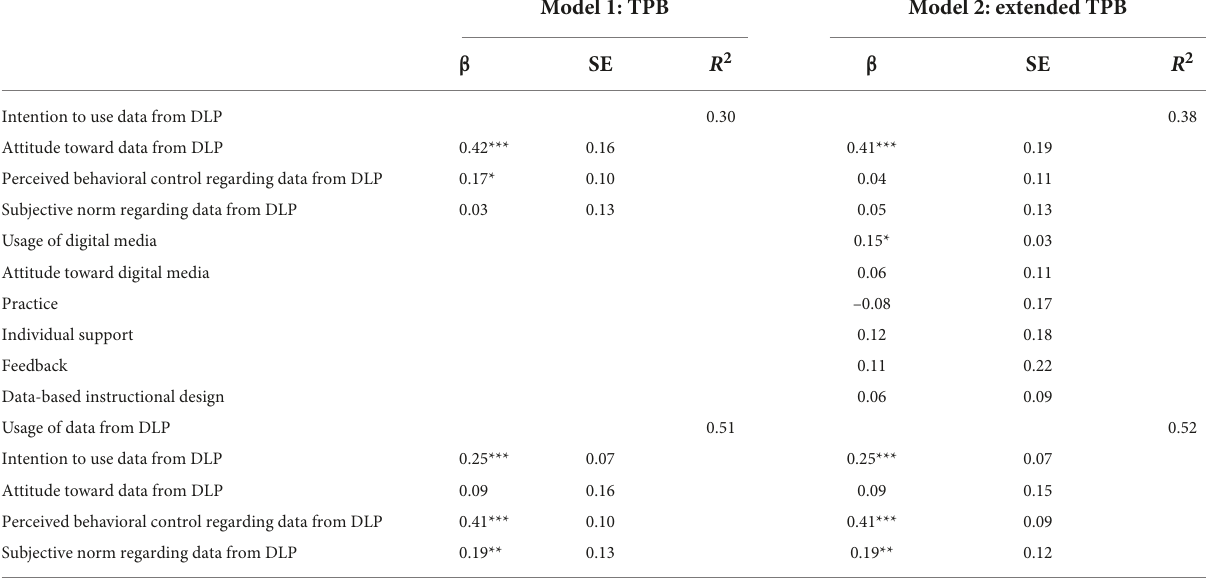
TABLE 4 Standardized beta values of all relationships in the structural equation model. Model 1: TPB Model 2: extended